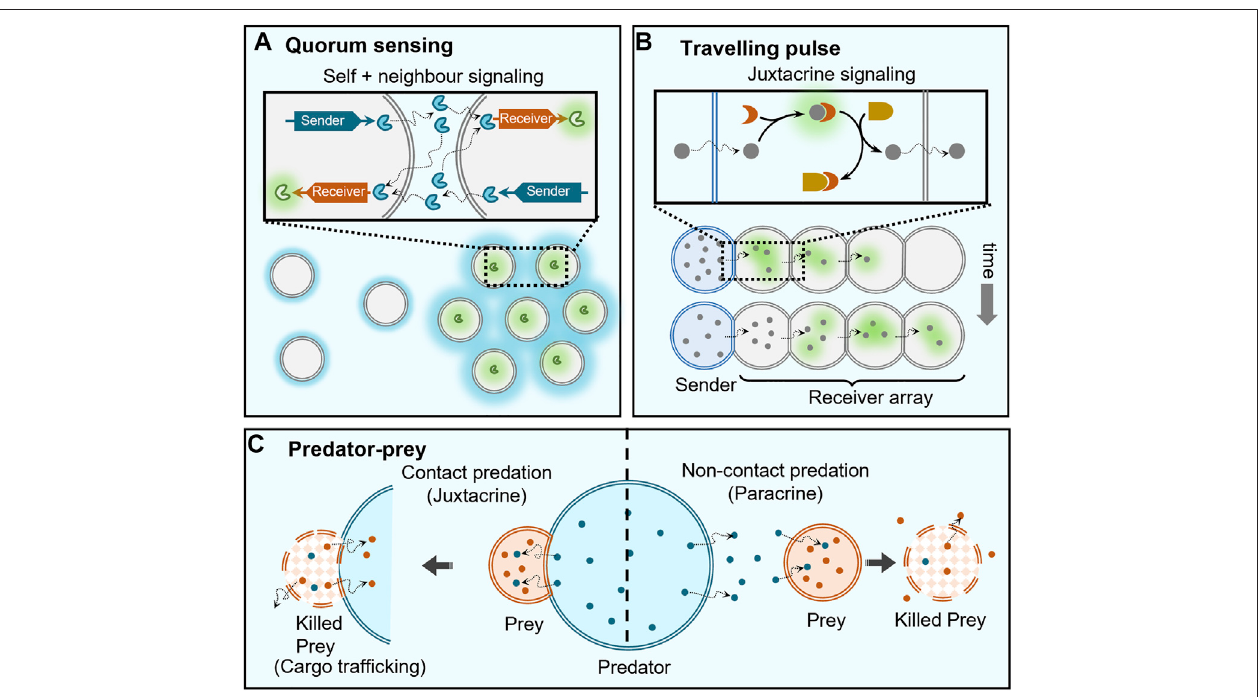
FIGURE4| Collectivebehaviours enabledbycell signaling. (A) Arti fi cial cellscapableofpopulation density-dependentbehavior,i.e. quorum sensing, containboth senderandreceiverDNAtemplatessothattheycanbothsendandreceiveproteinsignals(blue)totriggertheexpressionofagreen fl uorescentproteinathighpopulation densities, where the loss of self-generated signaling molecules by dilution is countered by the receipt of signals secreted by neighbouring cells (indicated by strong blue hues around clustered cells). (B) Travelling pulse behaviour in arti fi cial cells can be realized by propagation of signals from a single sender cell through an array of receiver cells, where the signaling molecules are capable ofdiffusing acrossthe membranes between the cells and are coupled to afeedforward genelet circuit. (C) Two types of predator-prey behaviour are observed depending on the distance between predator and prey: contact predation, when they are in direct contact allowing immediate degradation (killing) and traf fi cking of contents of prey cell, and non-contact predation, when they are separated by small distances ( L ≥ d ) leading to slow degradation of prey